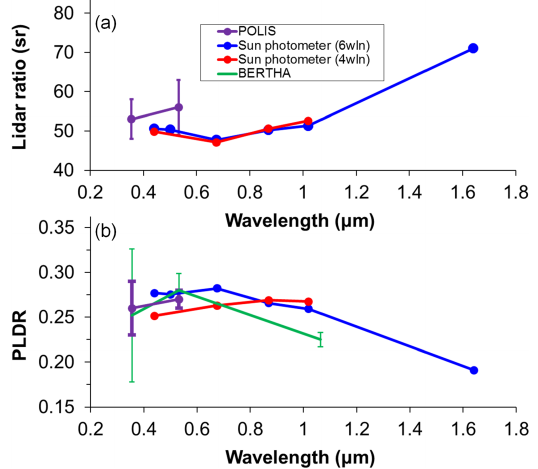
Figure 7. Wavelength dependence of the (a) lidar ratio (LR) and (b) particle linear depolarization ratio (PLDR), for dust cases during SALTRACE. Data from POLIS (Groß et al., 2015) and BERTHA (Haarig et al., 2017) are compared to the four-wavelength and six- wavelength sun photometer retrievals. Vertical bars in the lidar data indicate uncertainty due to systematic